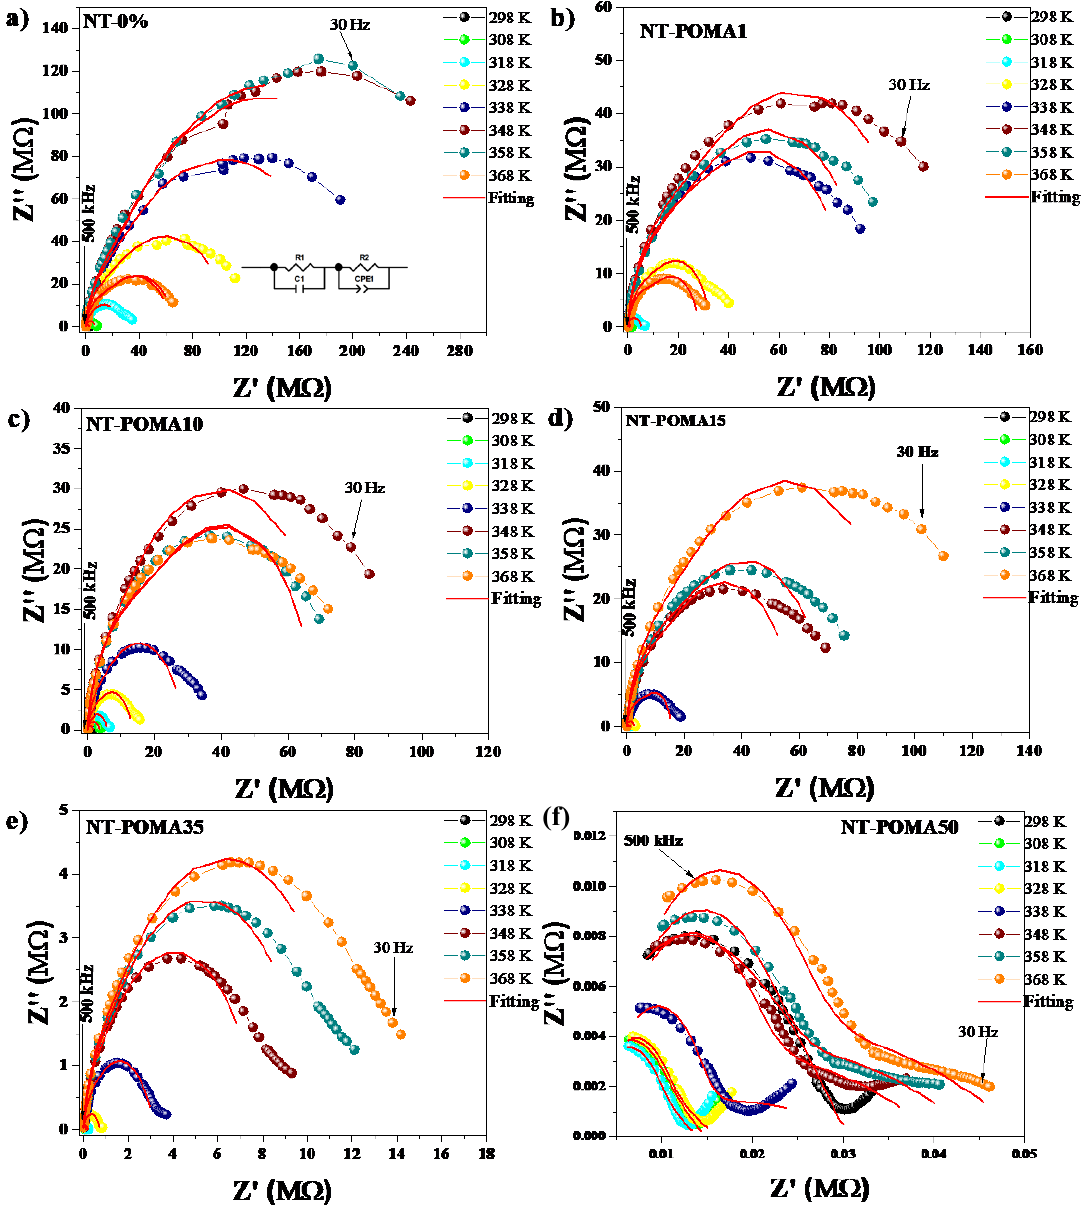
Figure 3. Isotherms of the Cole–Cole diagrams, with the behavior of the real (Z’) and imaginary (Z”) part of the complex impedance for all the composites. The red lines correspond to fits using the equivalent circuit model. ( a ) NT, ( b ) NT-POMA1, ( c ) NT-POMA10, ( d ) NT-POMA15, ( e ) NT-POMA35 and ( f ) NT-POMA50 samples correspond to 0.0%, 0.1%, 10%, 15%, 35% and 50% of POMA content, respectively. The equivalent circuit used for the fit is shown in the inset of Figure